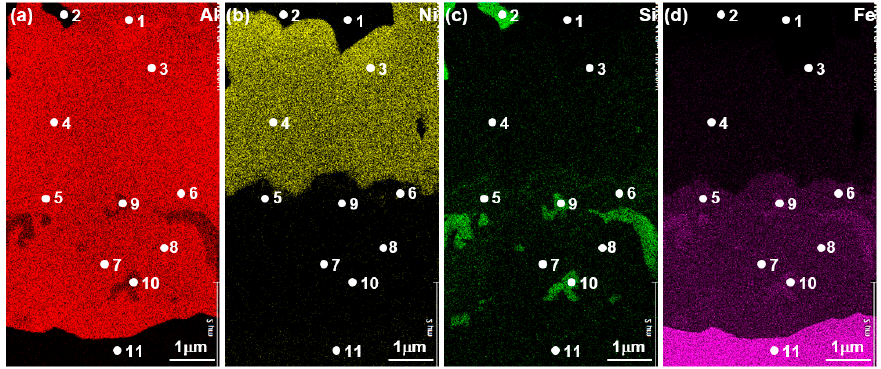
Figure 7. Results of EDS area-analysis of FE-TEM specimen: ( a ) Al, ( b ) Ni, ( c ) Si, and ( d ) Fe.